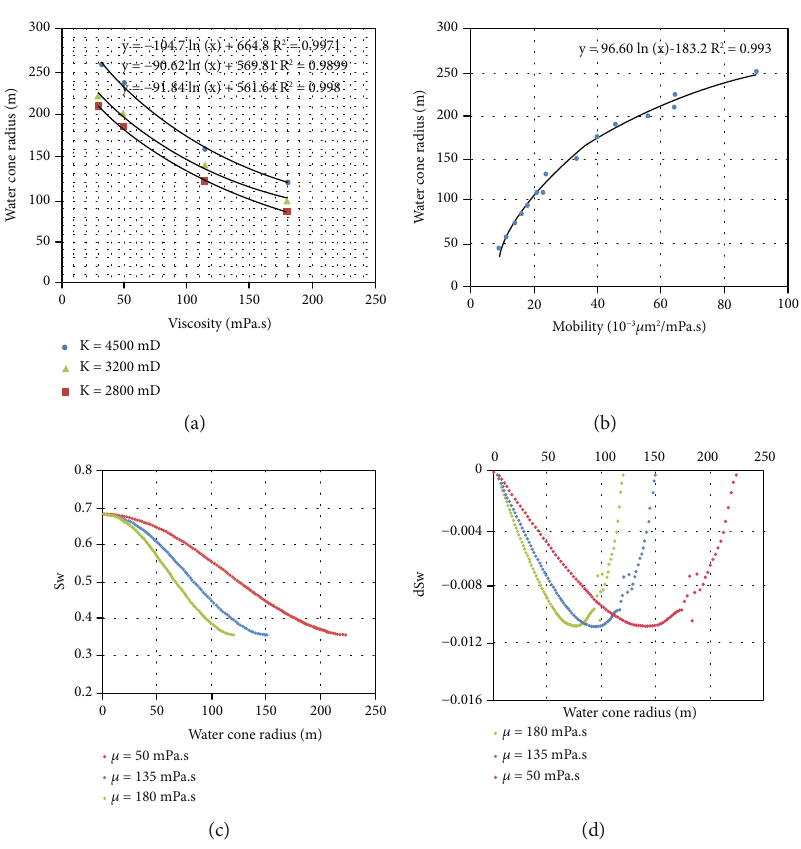
Figure 4: In fl uence of mobility on water cone